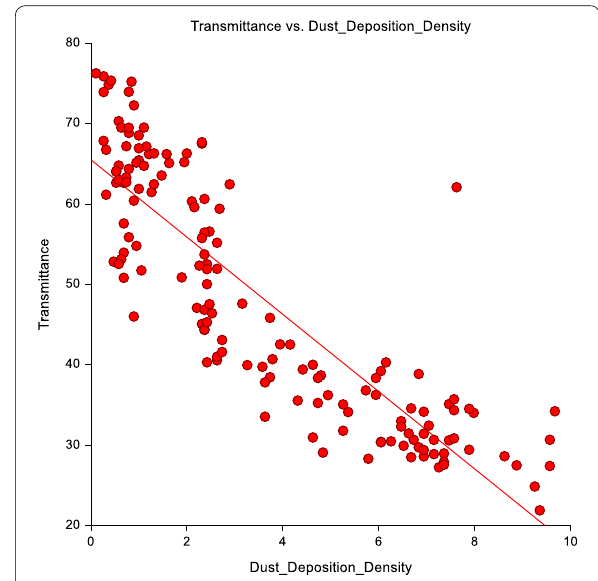
Fig. 9 Effect of dust deposition density (gm/m 2 ) in Transmittance